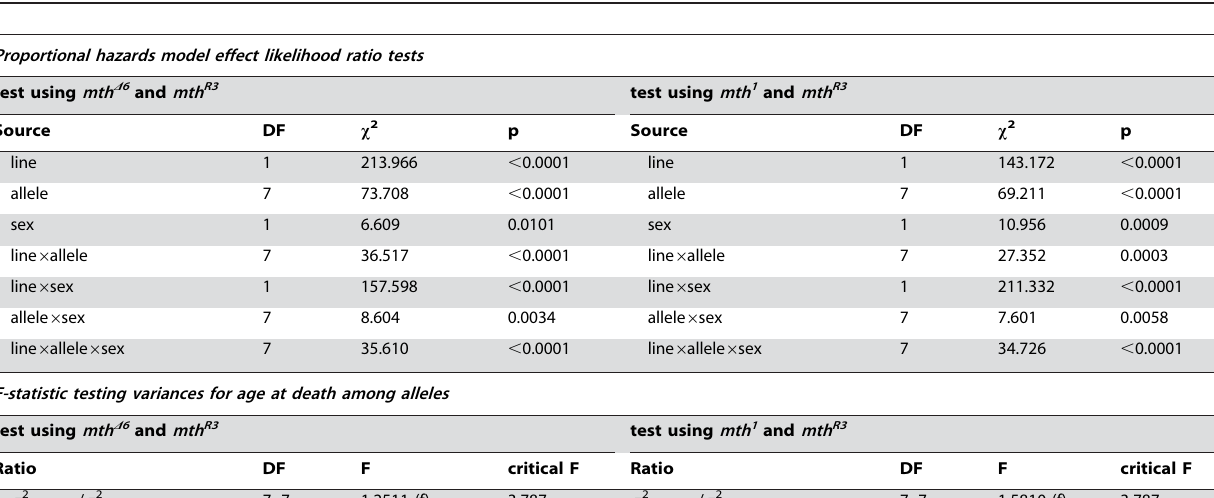
Table 1. Statistical results for the lifespan assay.